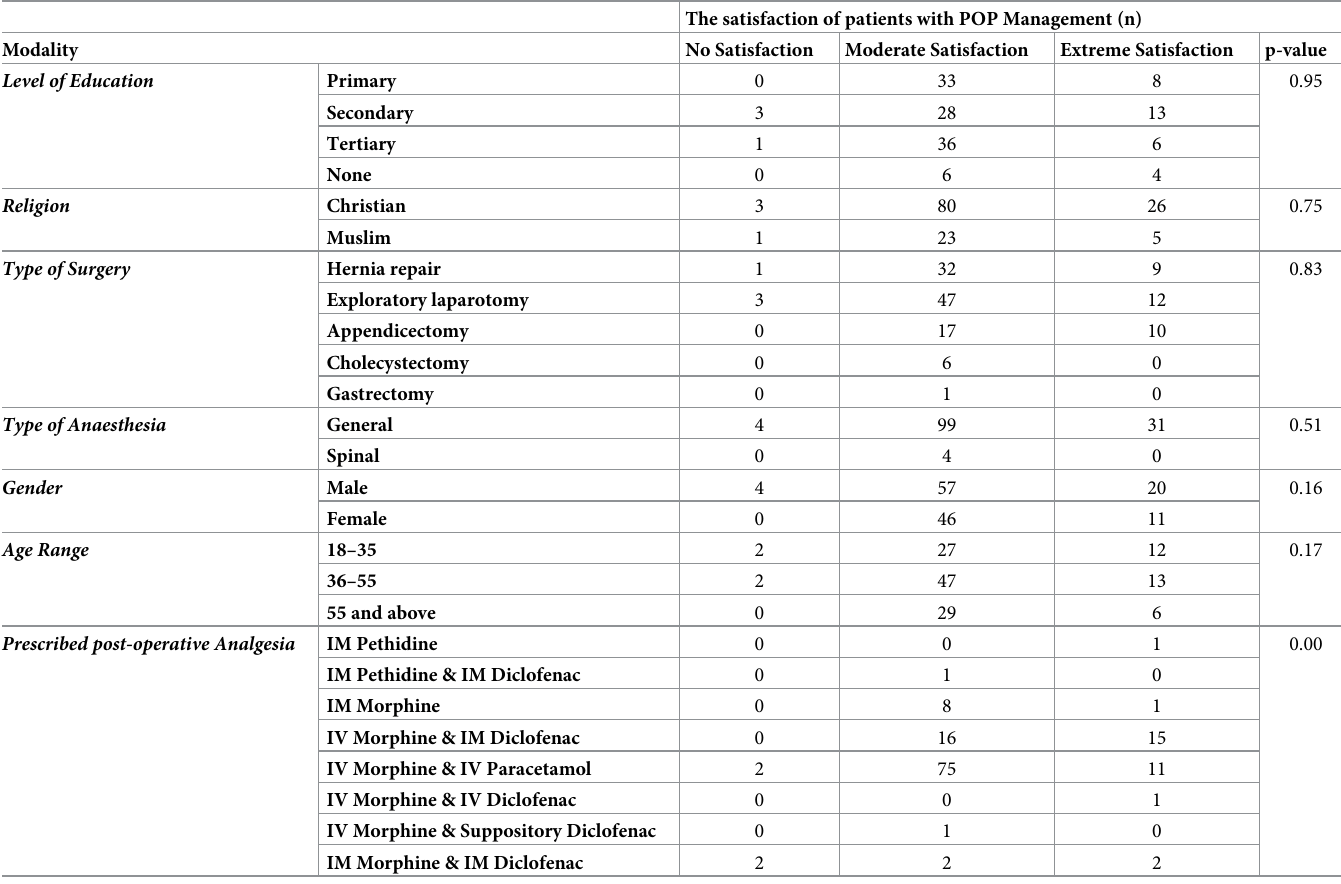
Table 3. Demographic and procedural characteristics of patients as predictors of satisfaction of post-operative pain management in